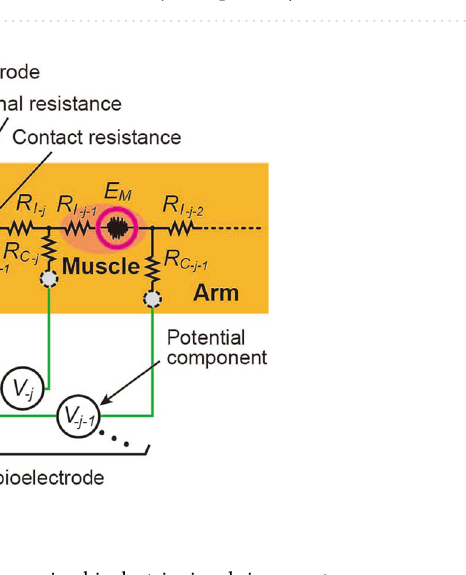
Figure 6. Electric-circuit model of novel method for measuring bioelectric signals in